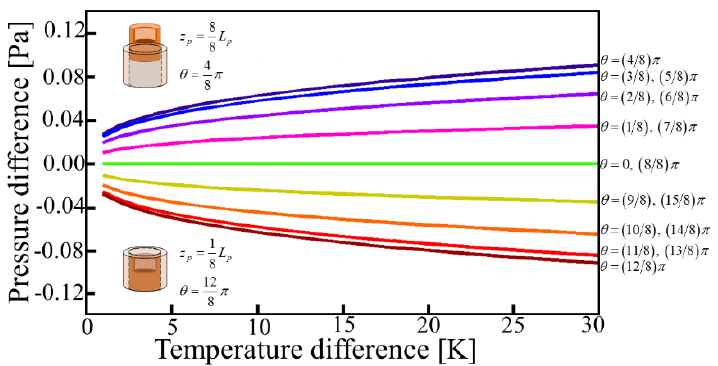
Figure 6. Pressure difference lines ( ∆ p ( θ ) = p h ( θ ) − p c ( θ )) in the air room at different θ values for different temperature differences between the cold and hot regions of the Stirling engine ( T 4 = 293 K, T 1 = 293–323 K).